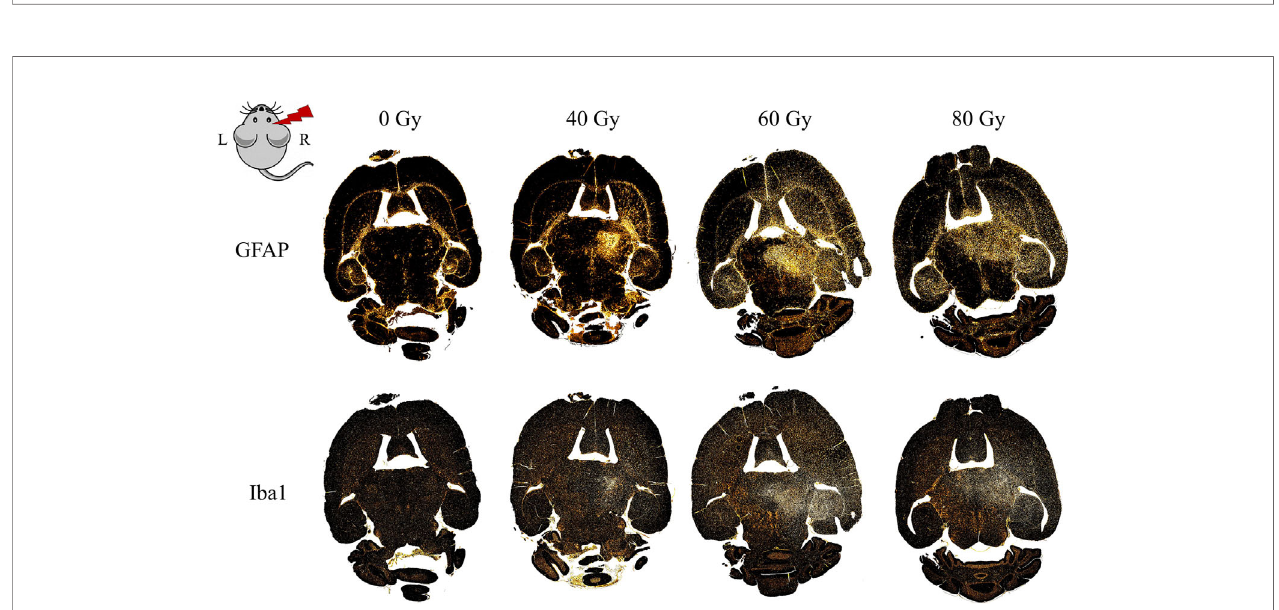
FIGURE 10 | Distribution of gliosis in the proton irradiated C3H/He mouse brain. Gliosis is indicated by an increased number of astrocytes (GFAP, upper row) and microglia (Iba1, lower row) within the irradiated fi eld and, for higher doses, also in the contralateral hippocampus. Staining was either performed within the same slice or in consecutive ones (within 15 µm distance, due to adaption of the staining protocol).